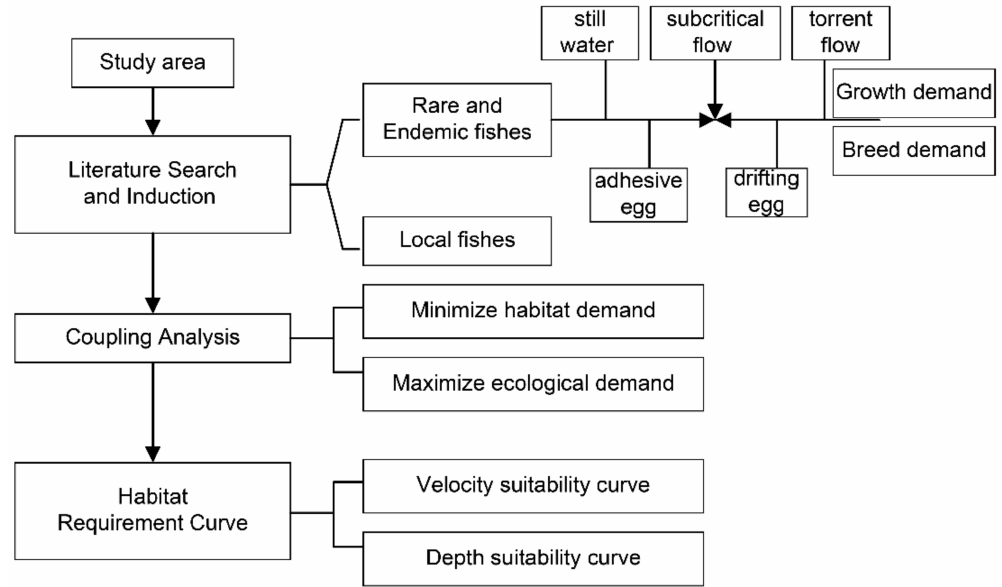
Figure 3. General workflow of coupled habitat demand analysis for several kinds of